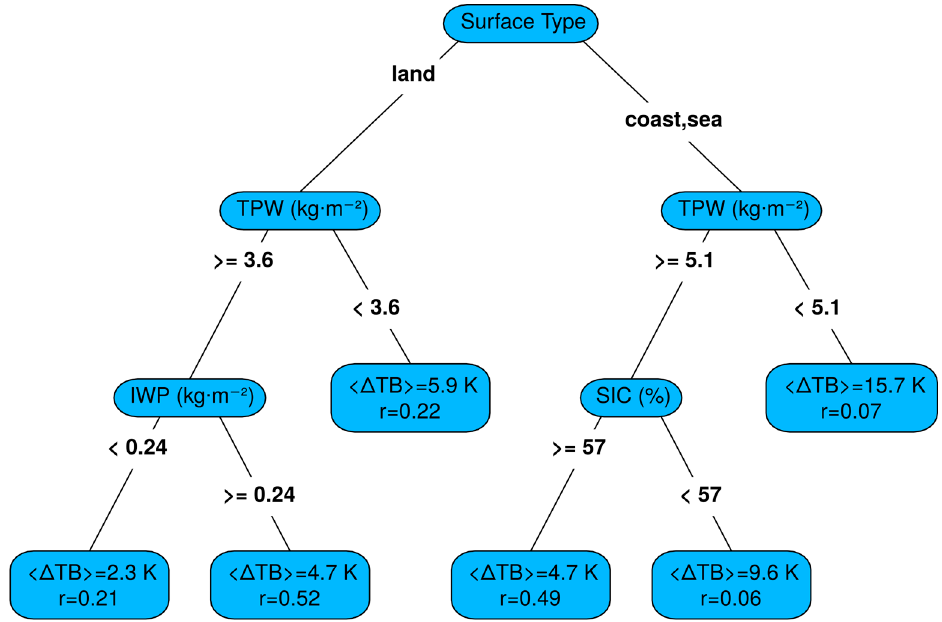
Figure 5. Regression tree results for 166 ∆ TB (target variable) using the GMI-CPR coincident dataset environmental variables and cloud properties as input variables. Each node (blue ovals) shows the relevant variable found by the tree (hierarchically from the top to the bottom). Each branch (or sub-group) is identified by the thresholds of the variable in the corresponding node and indicated on the black lines. For the final sub-groups, or final “leaves” (blue rectangles), the mean 166 ∆ TB value (< ∆ TB>), and the correlation coefficient (r) between 166 ∆ TB and SWP are provided. Only sub-groups containing at least 10% of the total number of observations are considered (see text for details).